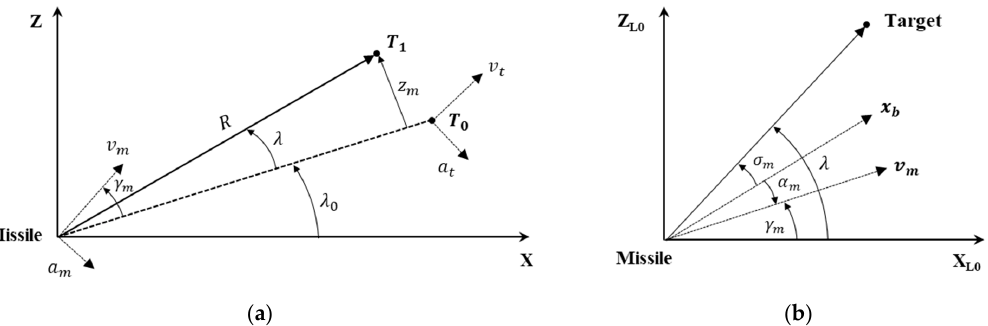
Figure 1. Missile terminal homing phase geometry in a two-dimensional plane ( a ) Planar engagement geometry; ( b ) engagement geometry defined on initial LOS frame.